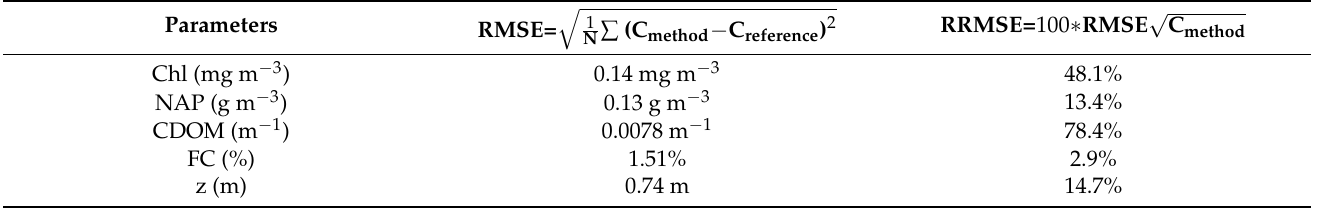
Table 1. Performances of the SRT inversion retrieval of the bio-optical parameters in clear waters.